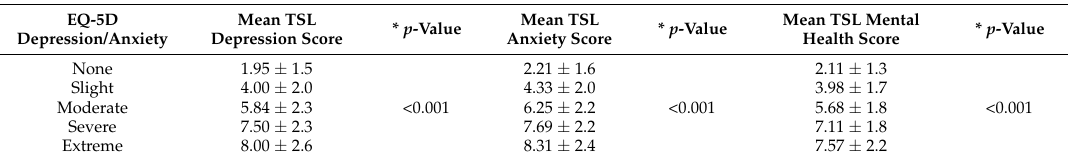
Table 2. Baseline Comparison of European Quality of Life Five Dimensions (EQ-5D-Rated) Level of Depression/Anxiety to Targeted Symptoms List (TSL) Scale Scores for Depression and Anxiety.